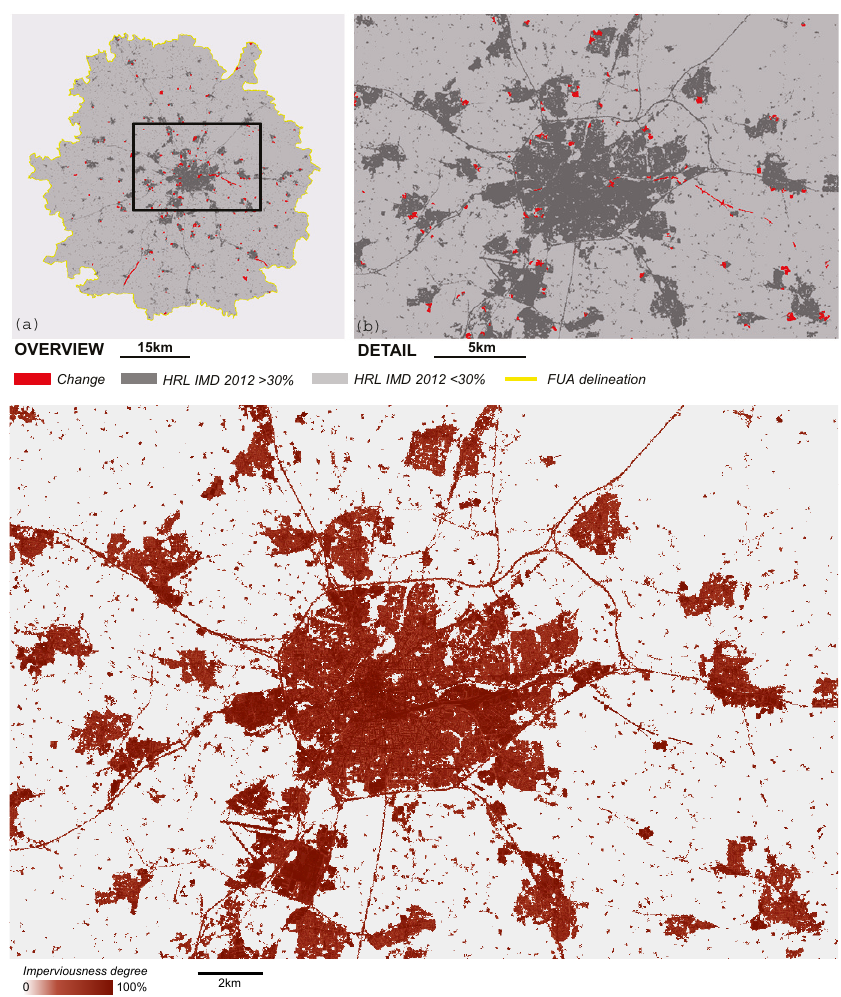
Figure 12. 2012 to 2015 change detection map in Rennes. Changes have been detected by comparison of the Copernicus HRL IMD (in 2012) and our product (in 2015). ( a ) The entire area; ( b ) a zoom of the black squared